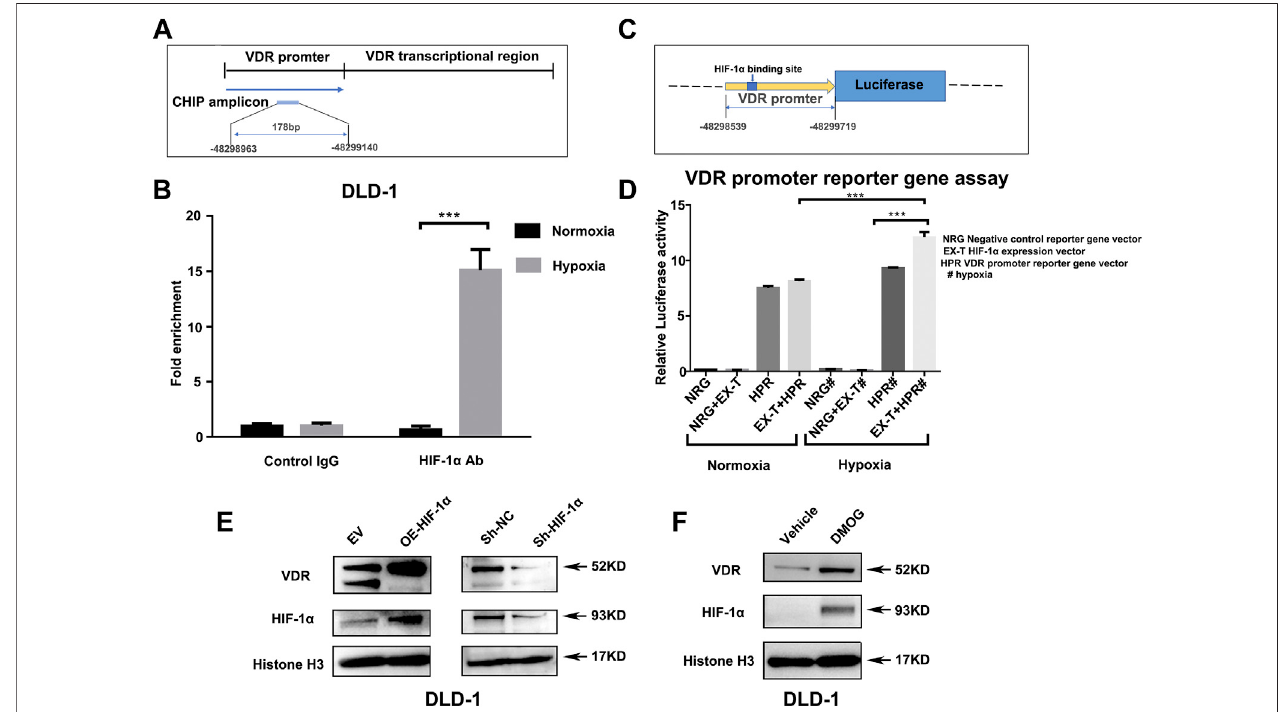
FIGURE 5 | HIF-1 α regulates the expression of VDR directly by binding to its promoter region. (A) : Schematic presentation of VDR DNA sequences used for Chip assay. (B) :ChromatinimmunoprecipitationanalysisshowingtheenrichmentofVDRDNAexpressioninthepromoterregionboundbytheHIF-1 α antibodyincomparison with the IgG negative control. Data are represented as mean ± standard error of mean (*** P < 0.001). VDR levels from three independent experiments performed using DLD-1. (C) : Schematic presentation of VDR promoter reporter plasmid containing the HIF-1 α binding site. (D) : Luciferase activity in 293T cells transfected with a negative control reporter gene vector (NRG), VDR promoter reporter gene vector HPRM30353-PG04 (HRP), or HIF-1 α expression vector EX-T0096-M02 (EX-T) separately (NRG or HPR) or together (NRG + EX-T or EX-T + HPR) under normoxia and hypoxia (*** P < 0.001, # represented hypoxia). (E) : Expression ofVDR after HIF- 1 α over-expression (OE) and HIF-1 α knock-down using lentiviral plasmids inDLD-1compared withtheircontrol[empty vector(EV) orsh-NC]separately. (F) :Expression of VDR after DMOG 1mM treated for 24 h in DLD-1.